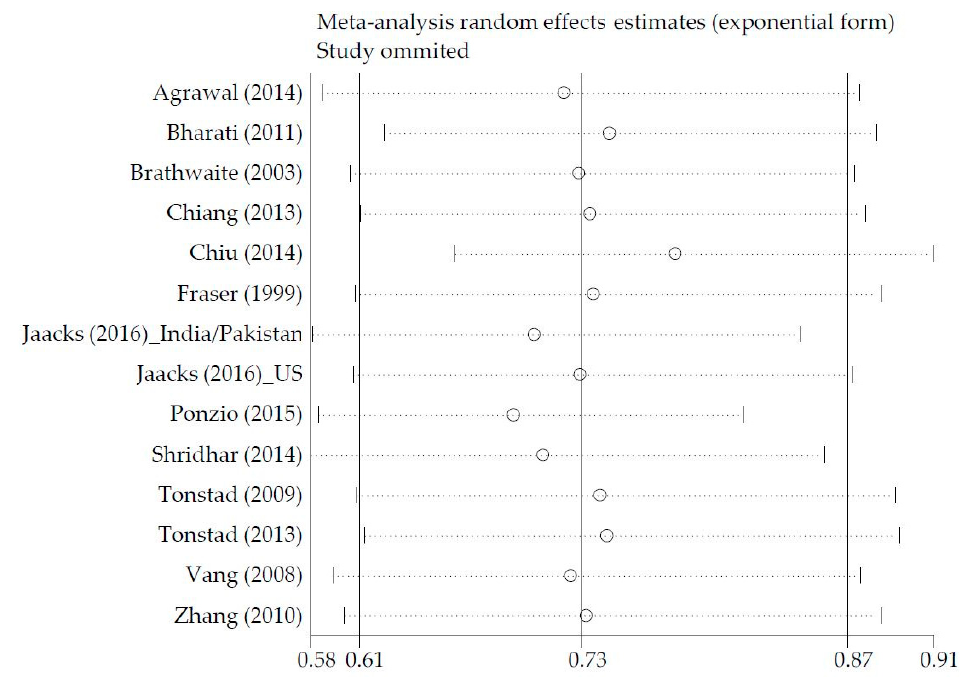
Figure 3. Influence analysis of pooled odds ratios.